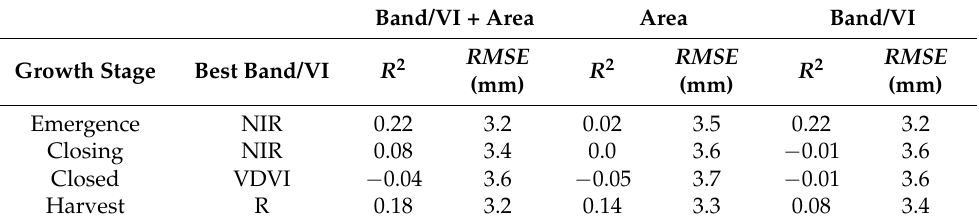
Table 6. Table beet root diameter growth stage and band/VI assessment report with leave-one-out cross-validation R 2 and root mean squared error (RMSE) for the best pairing of a radiometric feature with canopy area MLR model and the linear regression scores of the individual features in New York in